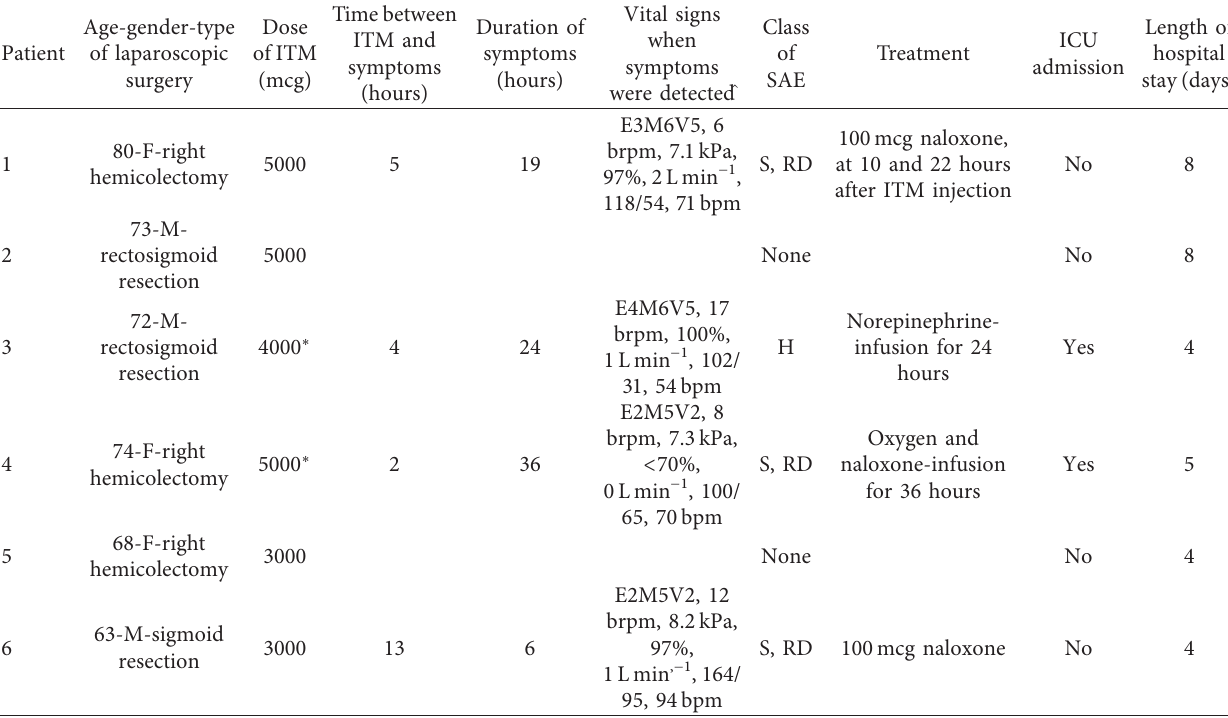
Table 1: Patients’